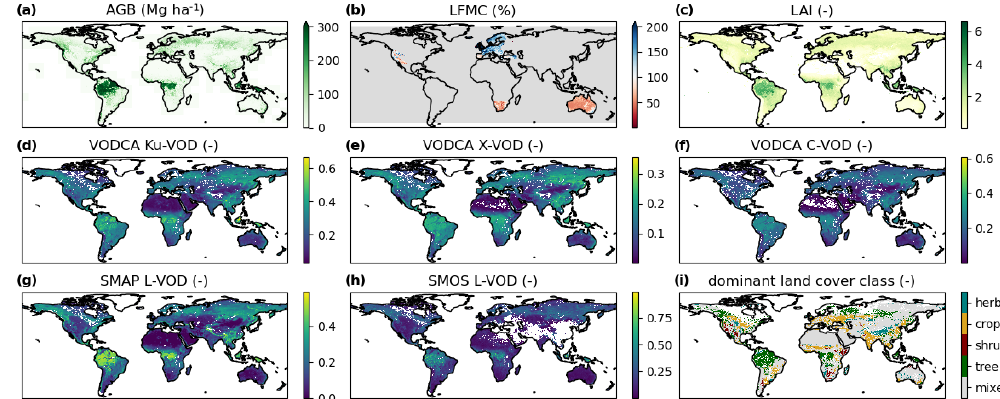
Figure 1. Overview of the datasets used for (a) above-ground biomass (AGB) for 2017 based on the ESA CCI biomass dataset; (b) live-fuel moisture content (LFMC) derived from MODIS, whereby grey indicates areas of non-available data; (c) the leaf area index (LAI) derived from MODIS; (d) Ku-band VOD (Ku-VOD) from VODCA; (e) X-band VOD (X-VOD) from VODCA; (f) C-band VOD (C-VOD) from VODCA; (g) L-band VOD from SMAP (SMAP L-VOD); (h) L-band VOD from SMOS (SMOS L-VOD); and (i) the dominant land cover class for 2016 based on the ESA CCI Land Cover map. LAI, LFMC, and VOD maps are temporal averages over the period January 2015– July 2017, whereby the VOD maps are based on data scaled to 0–1 for the available range within the mentioned time span. Note that LFMC is only available for the western USA, South Africa, Europe, and